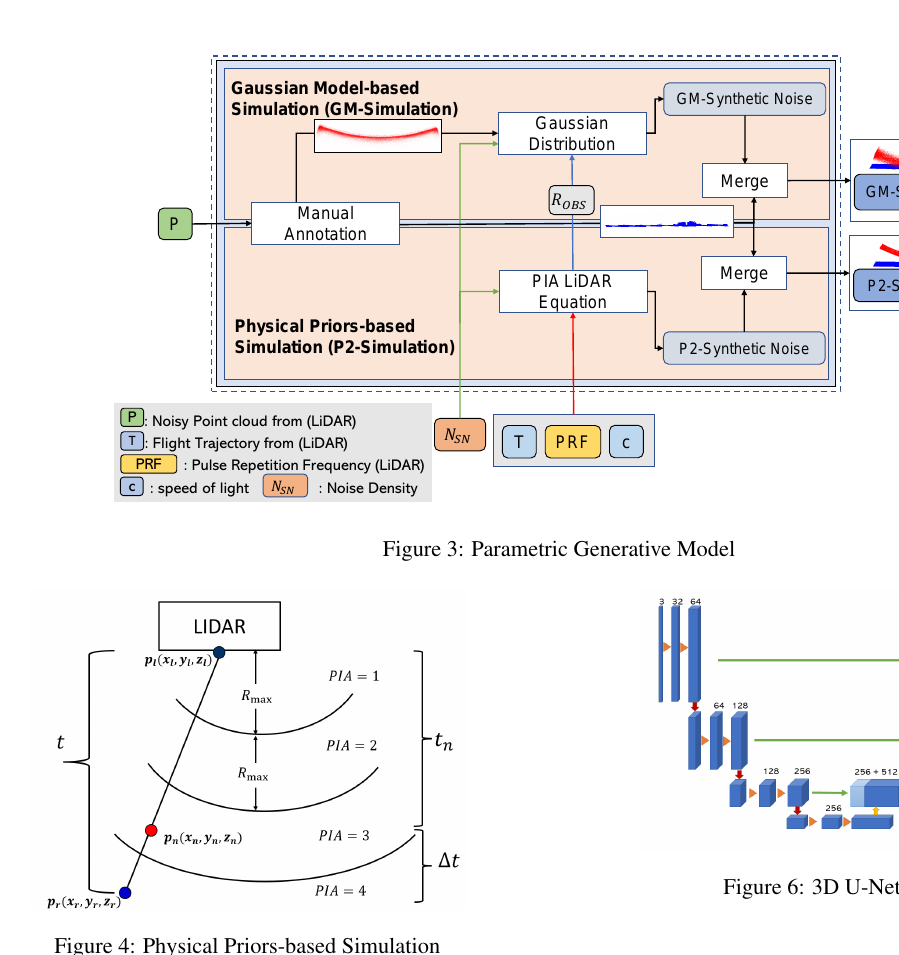
Figure 4: Physical Priors-based Simulation